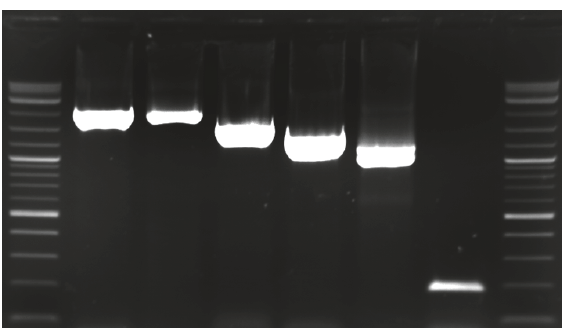
Figure 1: Characterization of virulence factors of H. pylori by PCR . Each lane shows different virulence factors of H. pylori strain isolatedfromhumansamples.M:Marker,A:babA(2192bp),B:cagA (1741 bp), C: VacA (1624 bp), D: AspA (1401 bp), E: HomB (1005 bp), and F: sabA (187